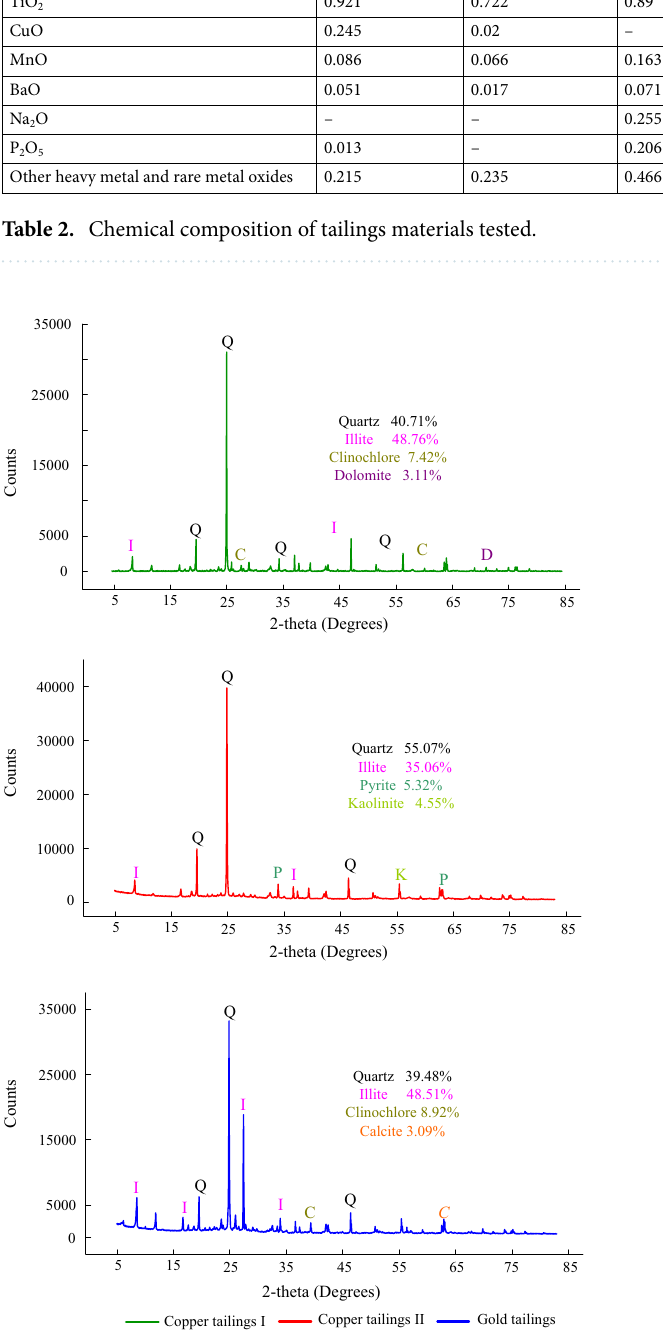
Figure 5. X-ray diffraction patterns of the three types of tailings [Q = quartz (00-046-1045); I = Illite (00-026- 0911); C = Clinochlore (00-079-1270); D = Dolomite (00-074-1687); P = Pyrite (00-042-1340); K = Kaolinite (00-074-1784); C = Calcite